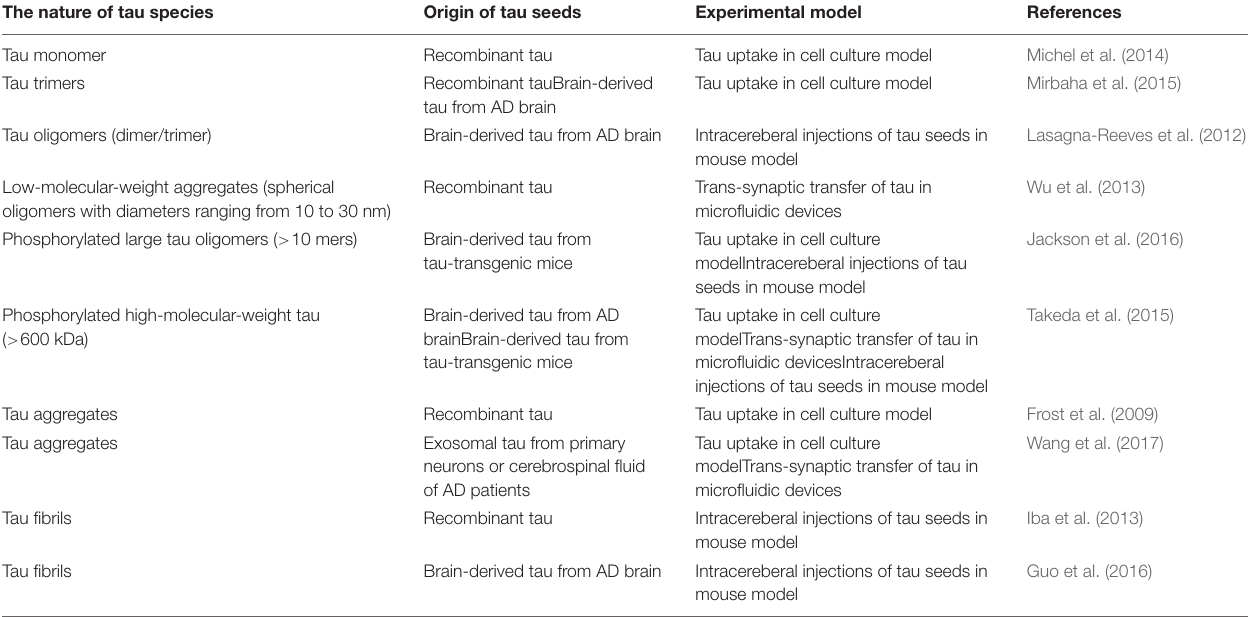
TABLE 1 | The nature of tau species involved in